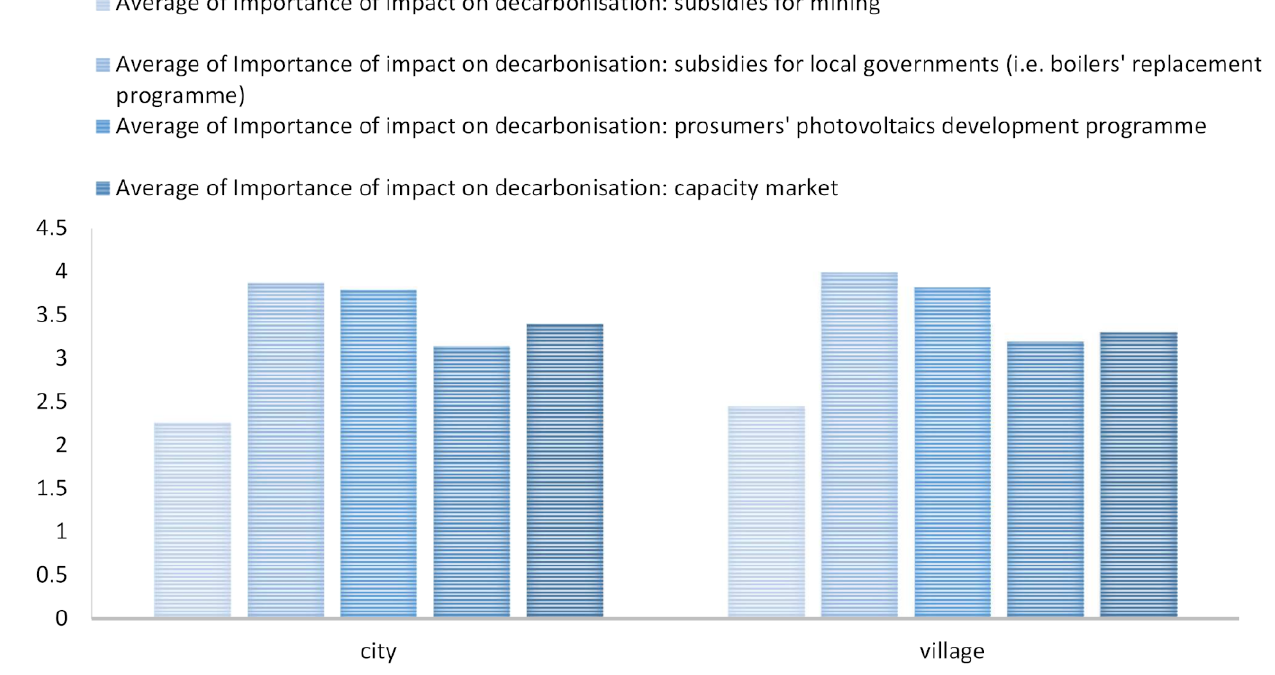
Figure 3. Average importance of impact on decarbonization. Source: Own research based on the results of an online survey, n = 444 (444 respondents who filled in the questionnaire online, of which 205 were men and 239 were